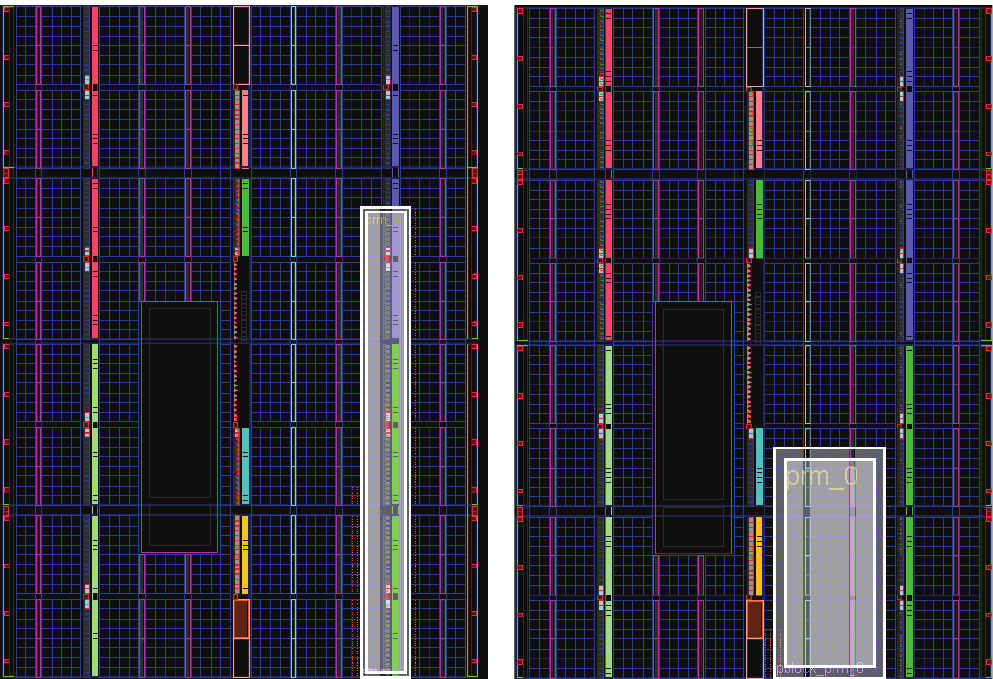
Figure 13: Dynamic reconfiguration region for (i) coe ffi cient-only reconfiguration system (left), and (ii) full-filter reconfiguration system